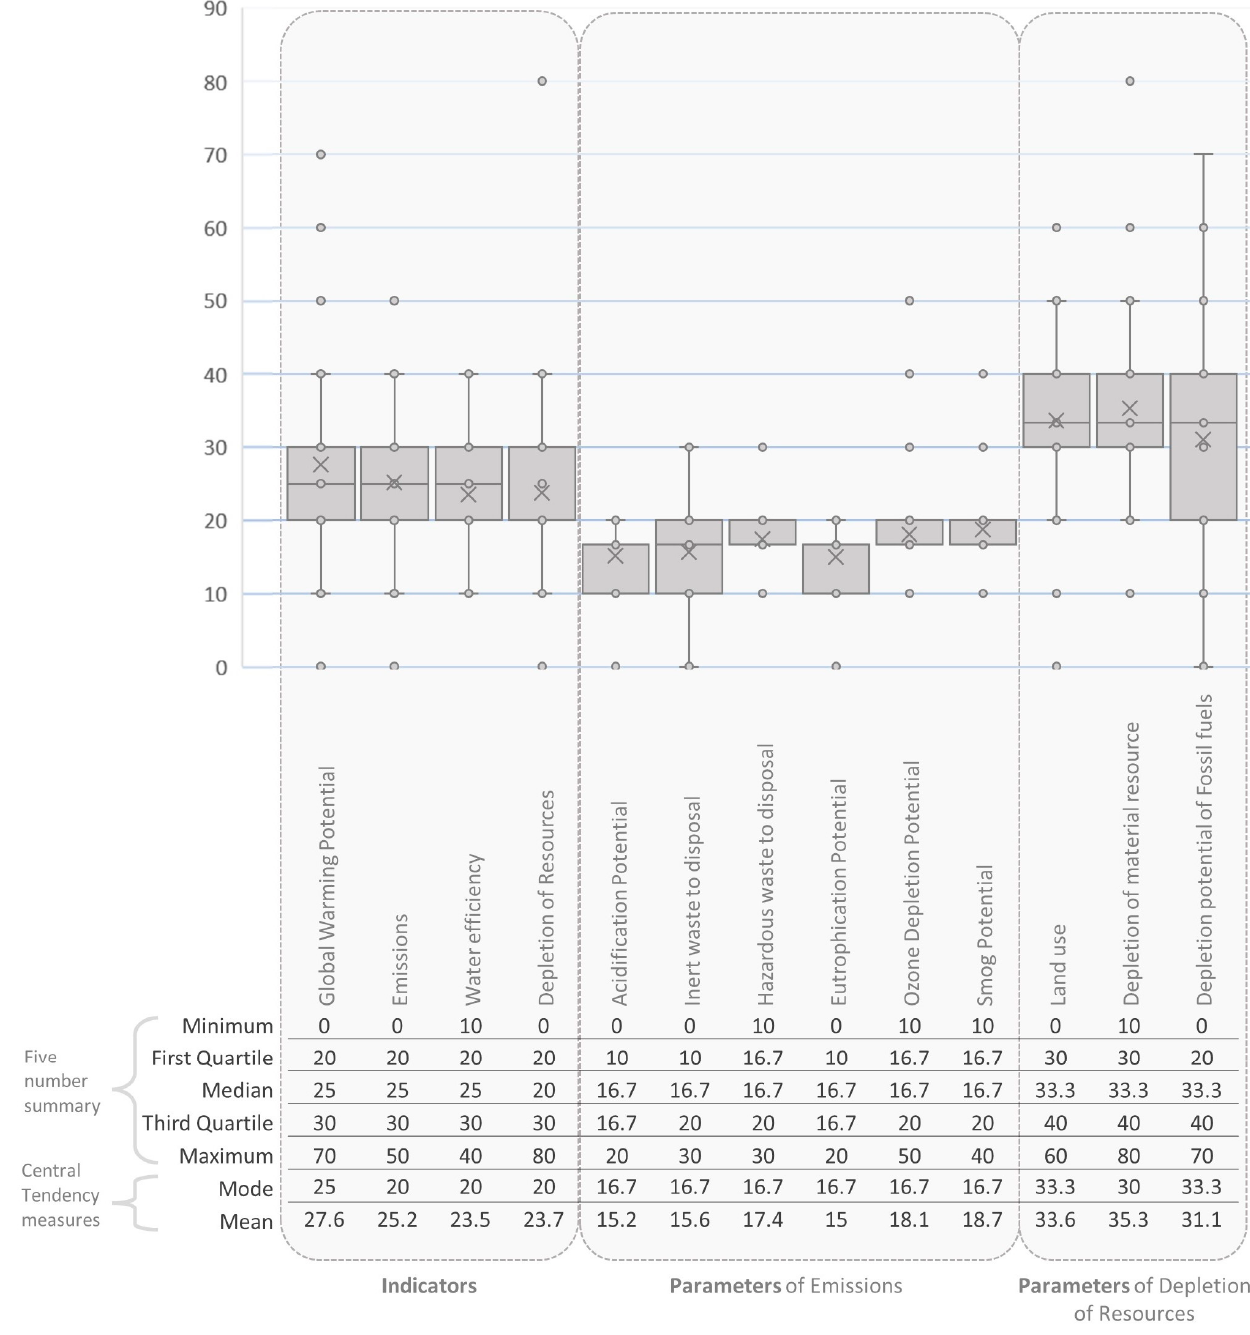
Figure 7. Box whisker plots for indicator and impact parameter weights. The relative weights given to different indicators and parameters by survey partic- ipants have been highlighted in Figure 8. Among the four inquired indicators, global warming potential (mean weight = 27.6%) and emissions (mean weight = 25.2%) were asso- ciated with the highest relative weights. The depletion of resources indicator is comprised of three parameters (see Figure 8). Among them, the highest relative weight was assigned to depletion of material resources (mean weight = 35.3%). Also, the emissions indicator is comprised of six parameters. Among them, the highest relative weights were given to smog potential (mean weight = 18.7%) and ozone depletion potential (mean weight = 18.1%);